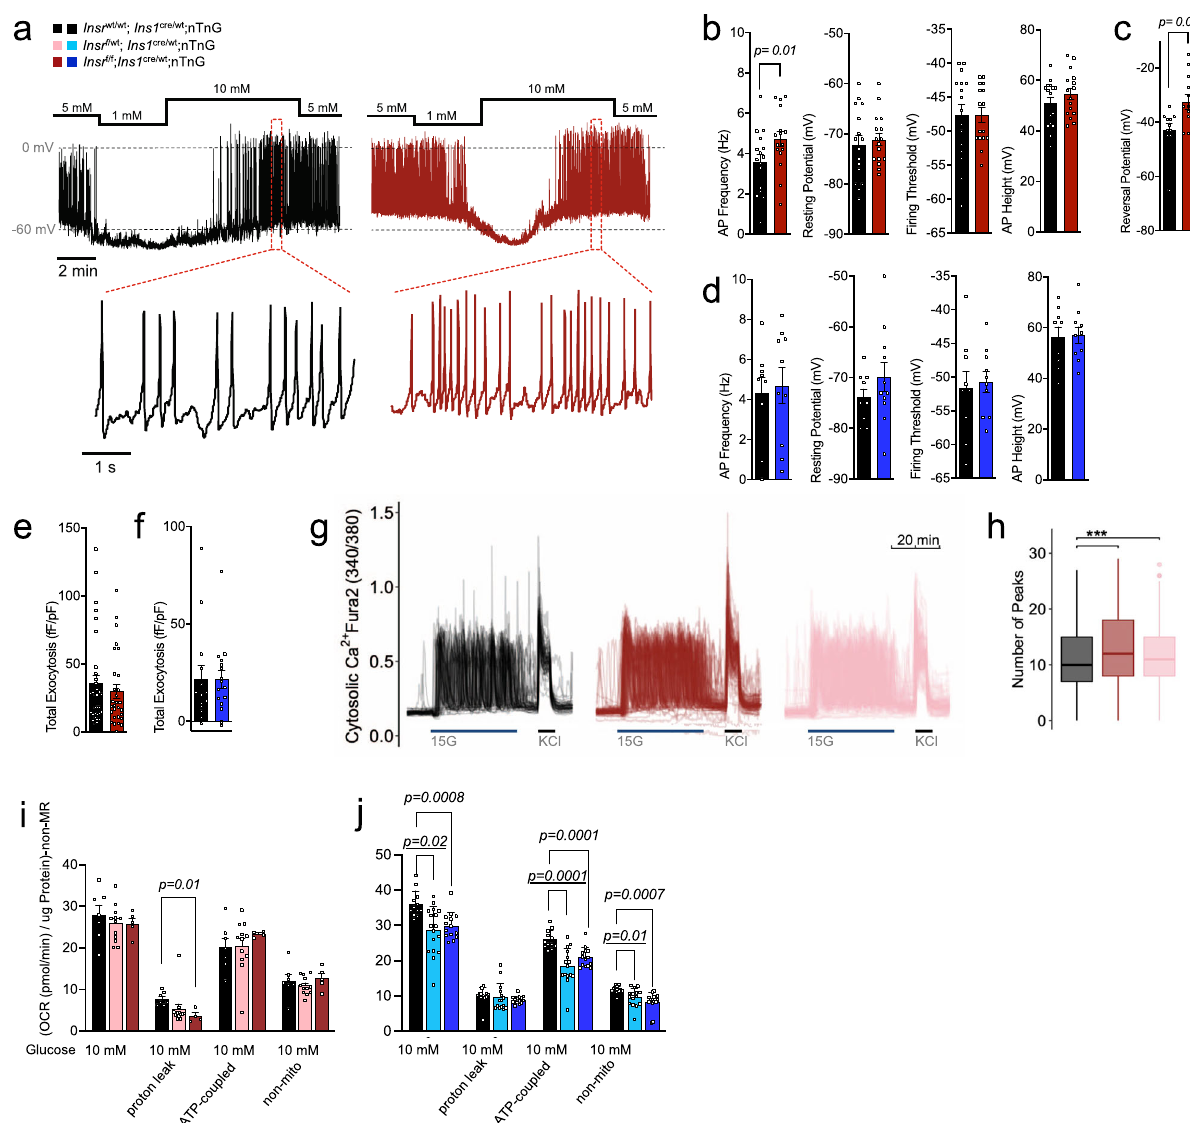
Fig. 3 β -Cells lacking Insr have increased action potential and calcium oscillation frequencies. a Representative traces of action potential fi ring in β -cells from 16 week-old chow-fed female mice ( n = 16 – 17 cells, from three mice per group). Glucose changed as indicated. b , c Quanti fi cation of action potential (AP) properties (Hz, mV) and reversal potential (mV) during the 10 mM glucose phase in patch clamped dispersed female β -cells ( n = 16 – 17 cells, from three mice per group). Unpaired two-sided student ’ s t -test. d Quanti fi cation of electrophysiological properties in islets from male mice ( n = 9 – 10 cells, from three mice per group). Unpaired two-sided student ’ s t -test. e , f β -Cell exocytosis measured as increased membrane capacitance normalized to initial cell size (fF/pF) over a series of ten 500 ms membrane depolarizations from − 70 to 0 mV ( n = control 32 cells, 29 β Insr KO cells, from three pairs of mice). Unpaired two-sided student ’ s t -test. g Ca 2 + dynamics measured in dispersed islet cells (Fura-2 340/380 ratio) treated as indicated from a baseline of 3 mM glucose) ( n = 3523 cells, 3 – 5 image areas per experiment, 1 – 2 independent islet cultures from six LFD-fed female 12-week old mice, two mice from each group). h Quanti fi cation of glucose induced Ca 2 + oscillation number ( n = see g ). ANOVA with correction for multiple comparisons using Tukey ’ s method. Additional quanti fi cation of these traces can be found in Fig. S2A. Boxplot; Minima: minimum outliers; Maxima: maximum outliers; Center: median; Bounds of box: fi rst to third quartile; Whiskers: the upper whisker extends from the hinge to the largest value no further than 1.5 * IQR from the hinge (where IQR is the inter-quartile range, or distance between the fi rst and third quartiles). The lower whisker extends from the hinge to the smallest value at most 1.5 * IQR of the hinge. i , j Oxygen consumption rate (OCR) data ((pmol/min) normalized to ug protein with non metabolic rate (non-MR) subtracted) of independent dispersed islet cultures from 16 week-old chow-fed control, β Insr HET , and β Insr KO mice (three male and one female mice from each group). Data were analyzed with a fi tted mixed-effects model with correction for multiple comparisons using Dunnett ’ s method. β Insr WT (black bars), β Insr HET (female = light pink bars, male = light blue bars) and β Insr KO (female = dark red bars, male = dark blue bars). All samples were handled in a strictly blinded manner. All data are presented as mean values + / − SEM. Source data are provided as Source Data fi with reduced β -cell Insr signaling at multiple ages, and in young experimentally, we examined glucose tolerance in female and males (Fig. 7). Consistent with our mathematical modeling that male β Insr KO , β Insr HET , and control littermates at multiple ages between 4 and 52 weeks in the context of two diets. Signi fi cant suggested a diminished contribution of β -cell insulin resistance to improvements in glucose tolerance were observed in female mice glucose homeostasis in the context of greater whole-body insulin